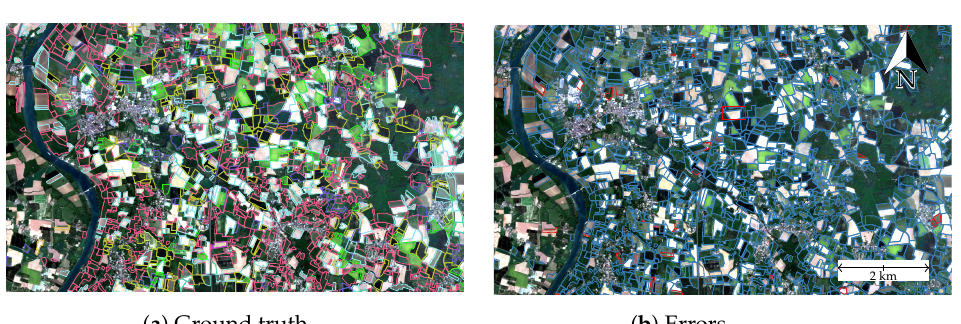
Figure 7. Qualitative Illustration. Detail of the area of interest with the ground truth in ( a ) and the qualification of the prediction in ( b ) with correct prediction in blue and errors in red.